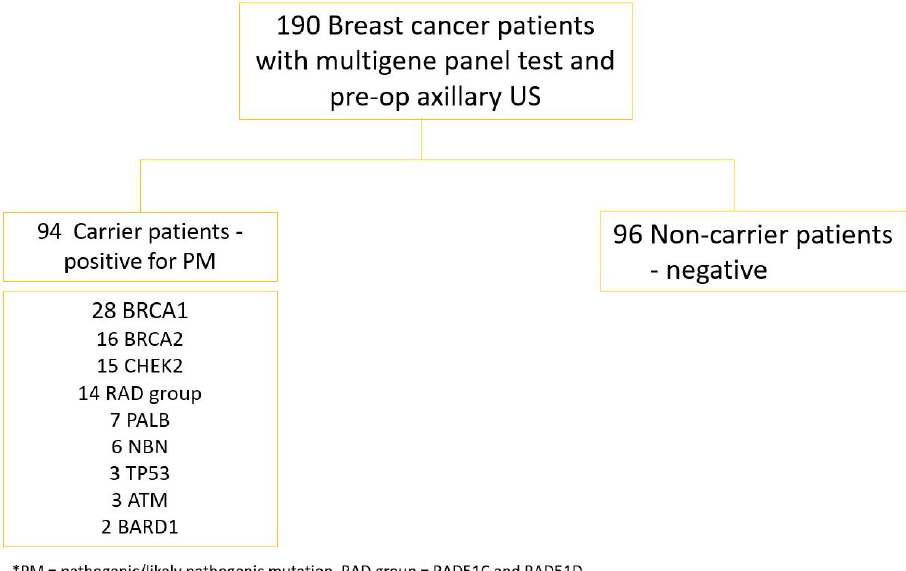
Figure 1. Study population.